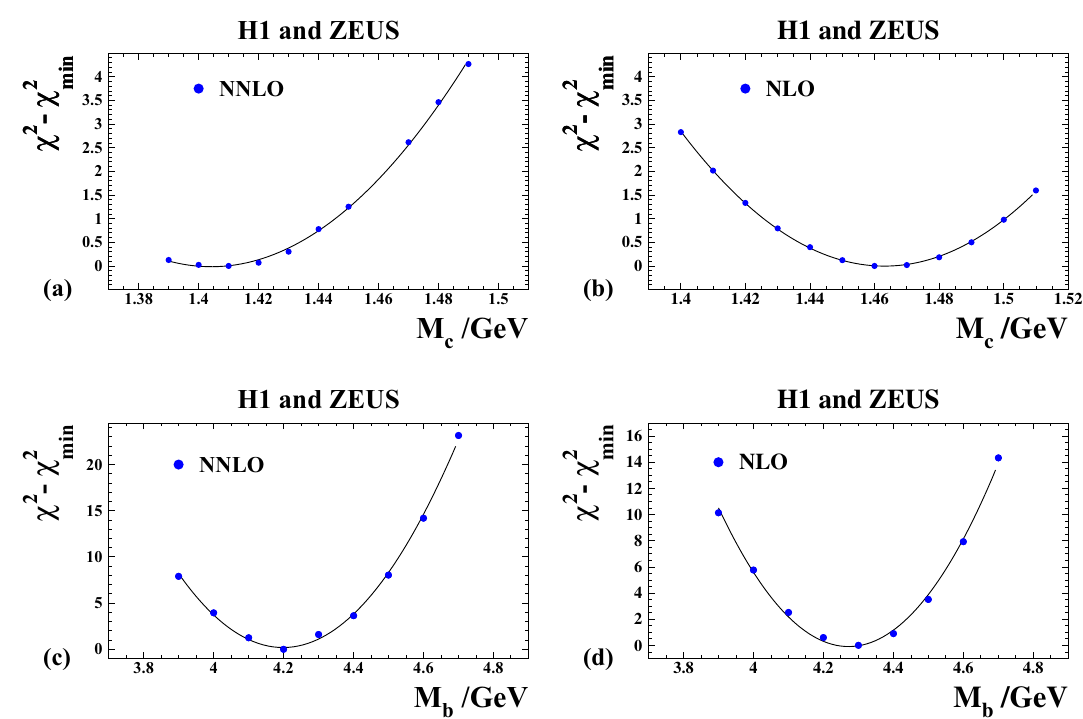
) = 0 . 1155, b M Z = 1 . 46GeV at NLO with α b with M c